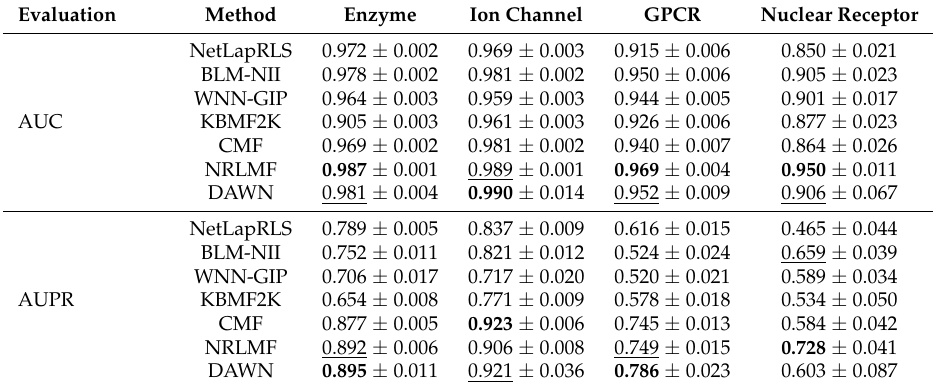
Figure 4. AUPR of imbalanced datasets by 10-fold cross-validation. ( a ) Enzyme’s PR curve with network feature. ( b ) IC’s PR curve with network feature. ( c ) GPCR’s PR curve with network feature. ( d ) Nuclear receptor’s PR curve with network feature. Table 4. Overall AUC and AUPR values of different methods on imbalanced dataset for four species.